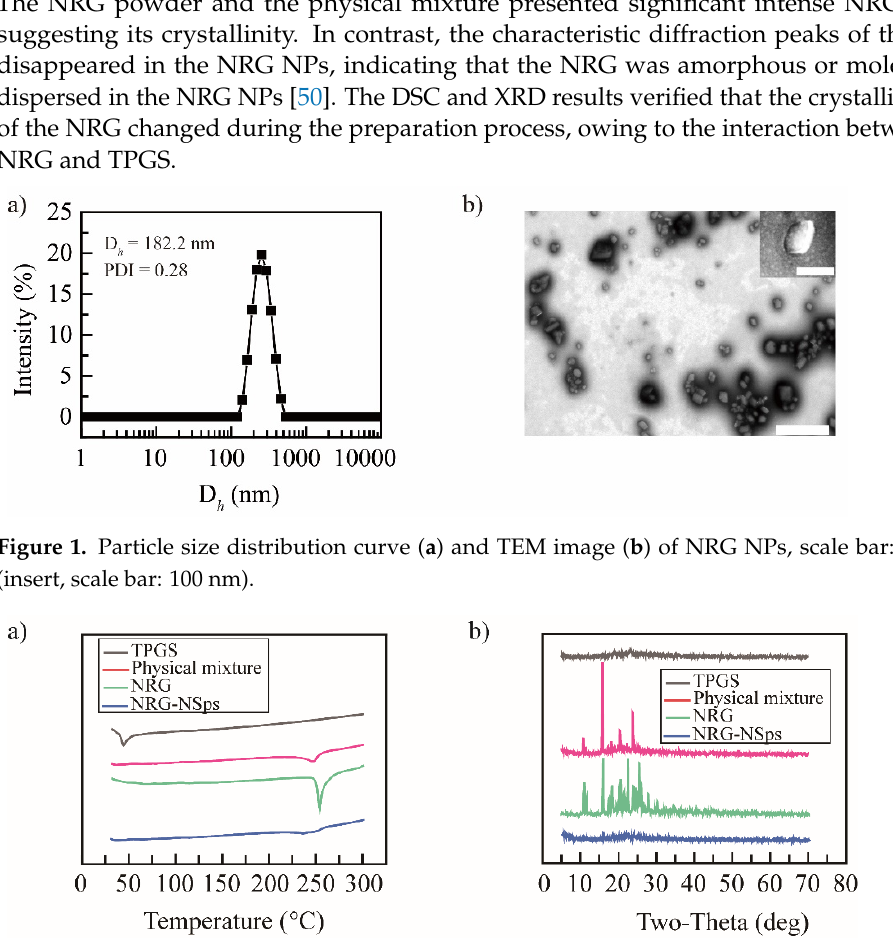
Figure 1. Particle size distribution curve ( a ) and TEM image ( b ) of NRG NPs, scale bar: 500 nm (insert, scale bar: 100 nm).